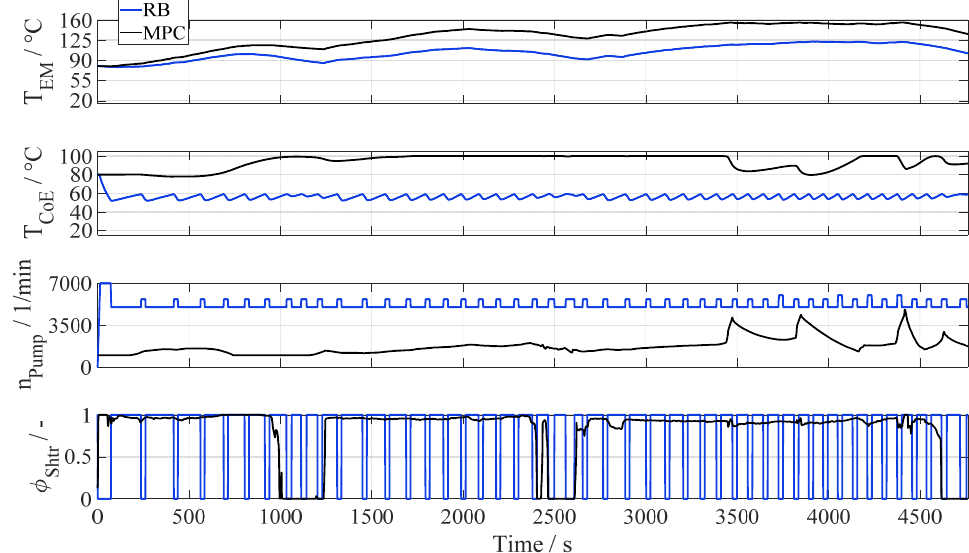
Figure 10. Comparison of MPC and rule-based strategy (RB) regarding motor temperature T EM , motor outlet coolant temperature T CoE , pump speed n Pump , and shutter position φ Shtr for the Highway Cycle at 80 ◦ C initial component temperature and 20 ◦ C ambient temperature.